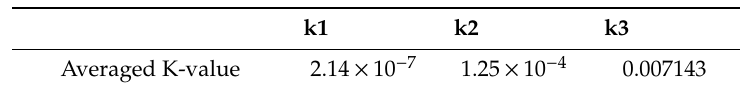
Table 4. Averaged K-values.